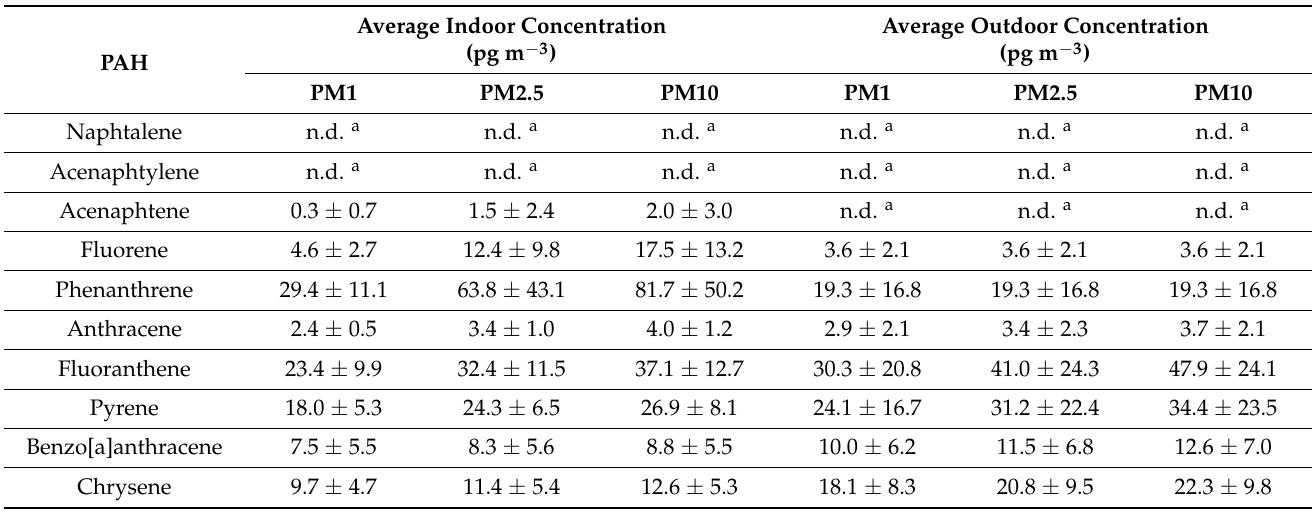
Table 2. Average indoor and outdoor concentrations of individual PAH over the full campaign duration. The quoted errors correspond to the standard deviation calculated from the six measurements performed on the investigated period.